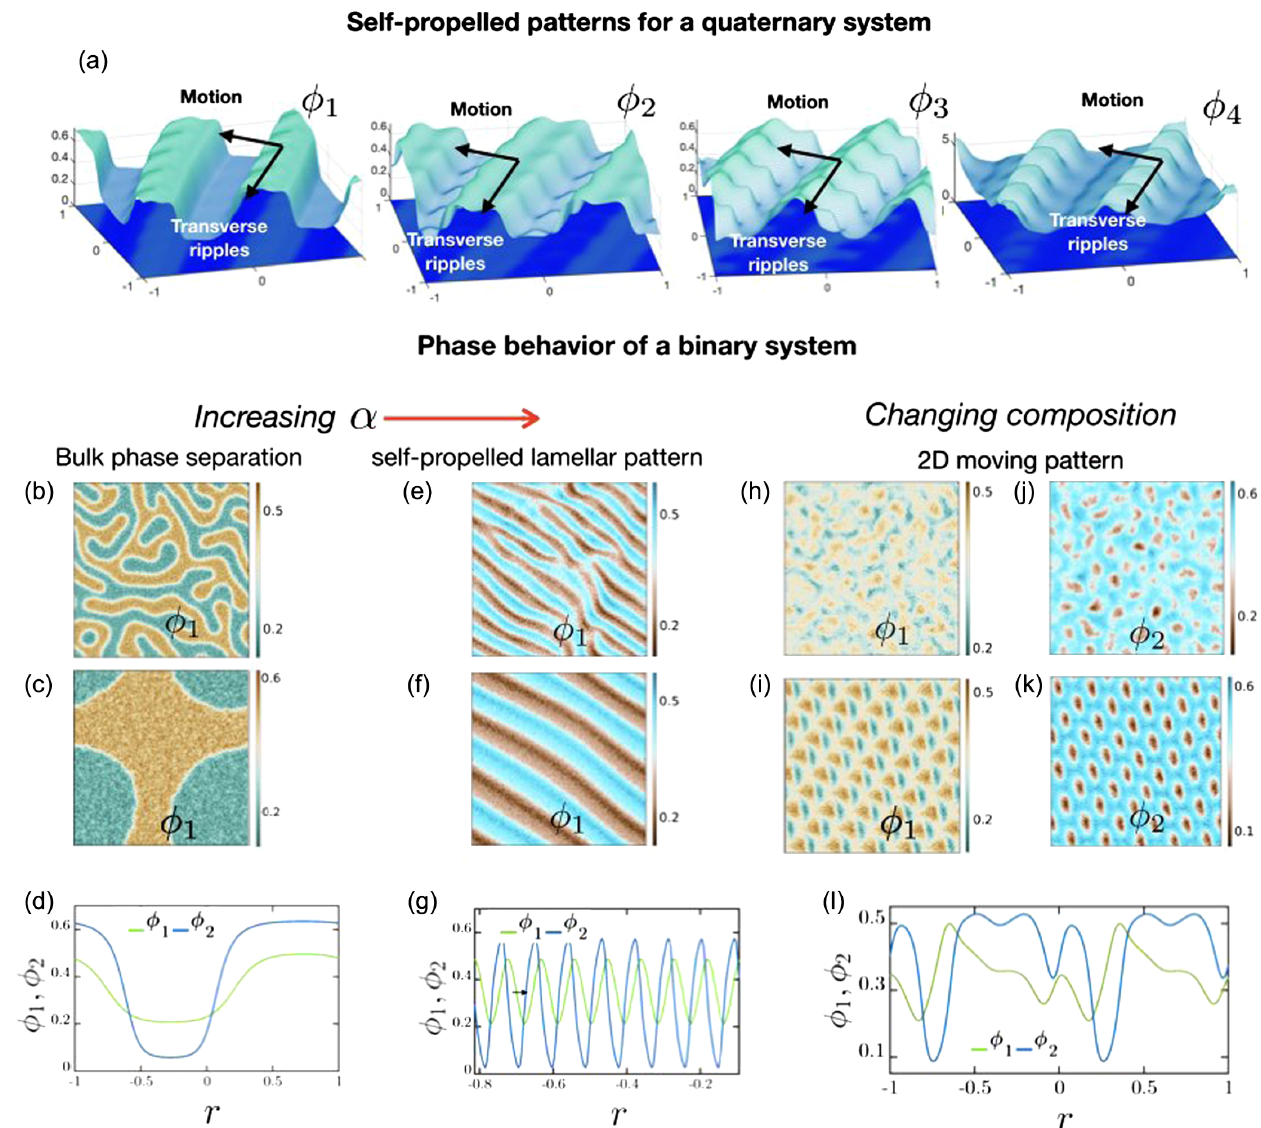
FIG. 1. Phase behavior exhibited by the NRCH model. (a) Example four-component system displaying self-propelled lamellar domains in the steady state. Ripples in density travel perpendicularly to the direction of motion. (b) – (l) Binary systems displaying [(b) – (d)] bulk phase separation at low activity ( α ¼ 0 . 2 ). At higher activity ( α ¼ 0 . 4 ), they undergo an oscillatory instability and display [(e) – (g)] a lamellar phase with self-propelled density bands or [(h) – (l)] two-dimensional moving micropatterns, depending on the system composition. In all cases, the top (b,e,h,j) and bottom (c,f,i,k) rows of snapshots correspond to intermediate and steady states, respectively, in simulations with Gaussian white noise. Line scans of the concentration along a cross section of the corresponding steady states in a noiseless simulation are shown in panels (d,g,l). (b) Coarsening of bulk phase separated states, which proceeds through system-spanning labyrinthine patterns as in equilibrium Cahn-Hilliard, (e) coarsening of self-propelled lamellar patterns through annihilation of defects, and (h,j) moving patterns arising from ordering of self-propelled domains. For the self-propelled lamellar and 2D patterns, the concentration profiles at steady state (g,l) show a fixed wavelength and a finite separation between the peaks of the two components, sustaining the motion due to nonreciprocal interactions. The parameters corresponding to panel (a) are described in the Appendix A. For panels (b) – (l), we used c 1 ; 1 ¼ 0 . 2 , c 1 ; 2 ¼ 0 . 5 , c 2 ; 1 ¼ 0 . 1 , c 2 ; 2 ¼ 0 . 5 , χ ¼ − 0 . 2 , χ 0 ¼ 0 and average densities ¯ ϕ 0 . 35 and ¯ ϕ 0 . 3 , with the exception of panels (h) – (l) for which ¯ ϕ 0 . 42 . The stiffness κ ¼ 0 . 0001 is the same in all 1 ¼ 2 ¼ 2 ¼ simulations. A system size of 201 × 201 and a time stepping of 10 − 4 are used in all of the simulations presented